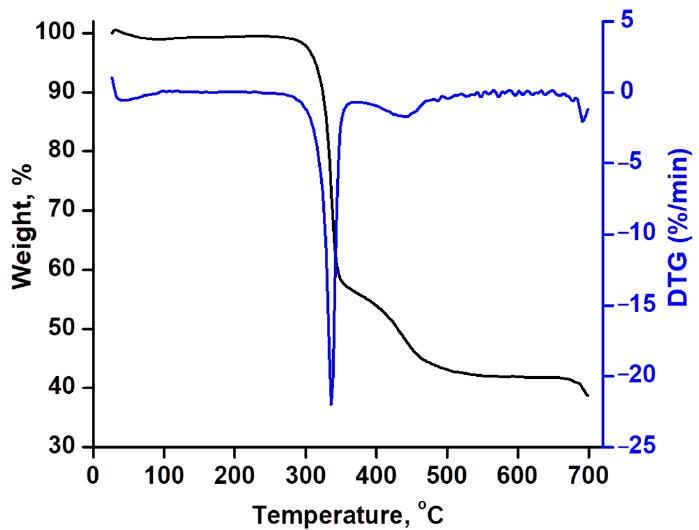
Figure 7. Thermogravimetric analysis of compound 1.